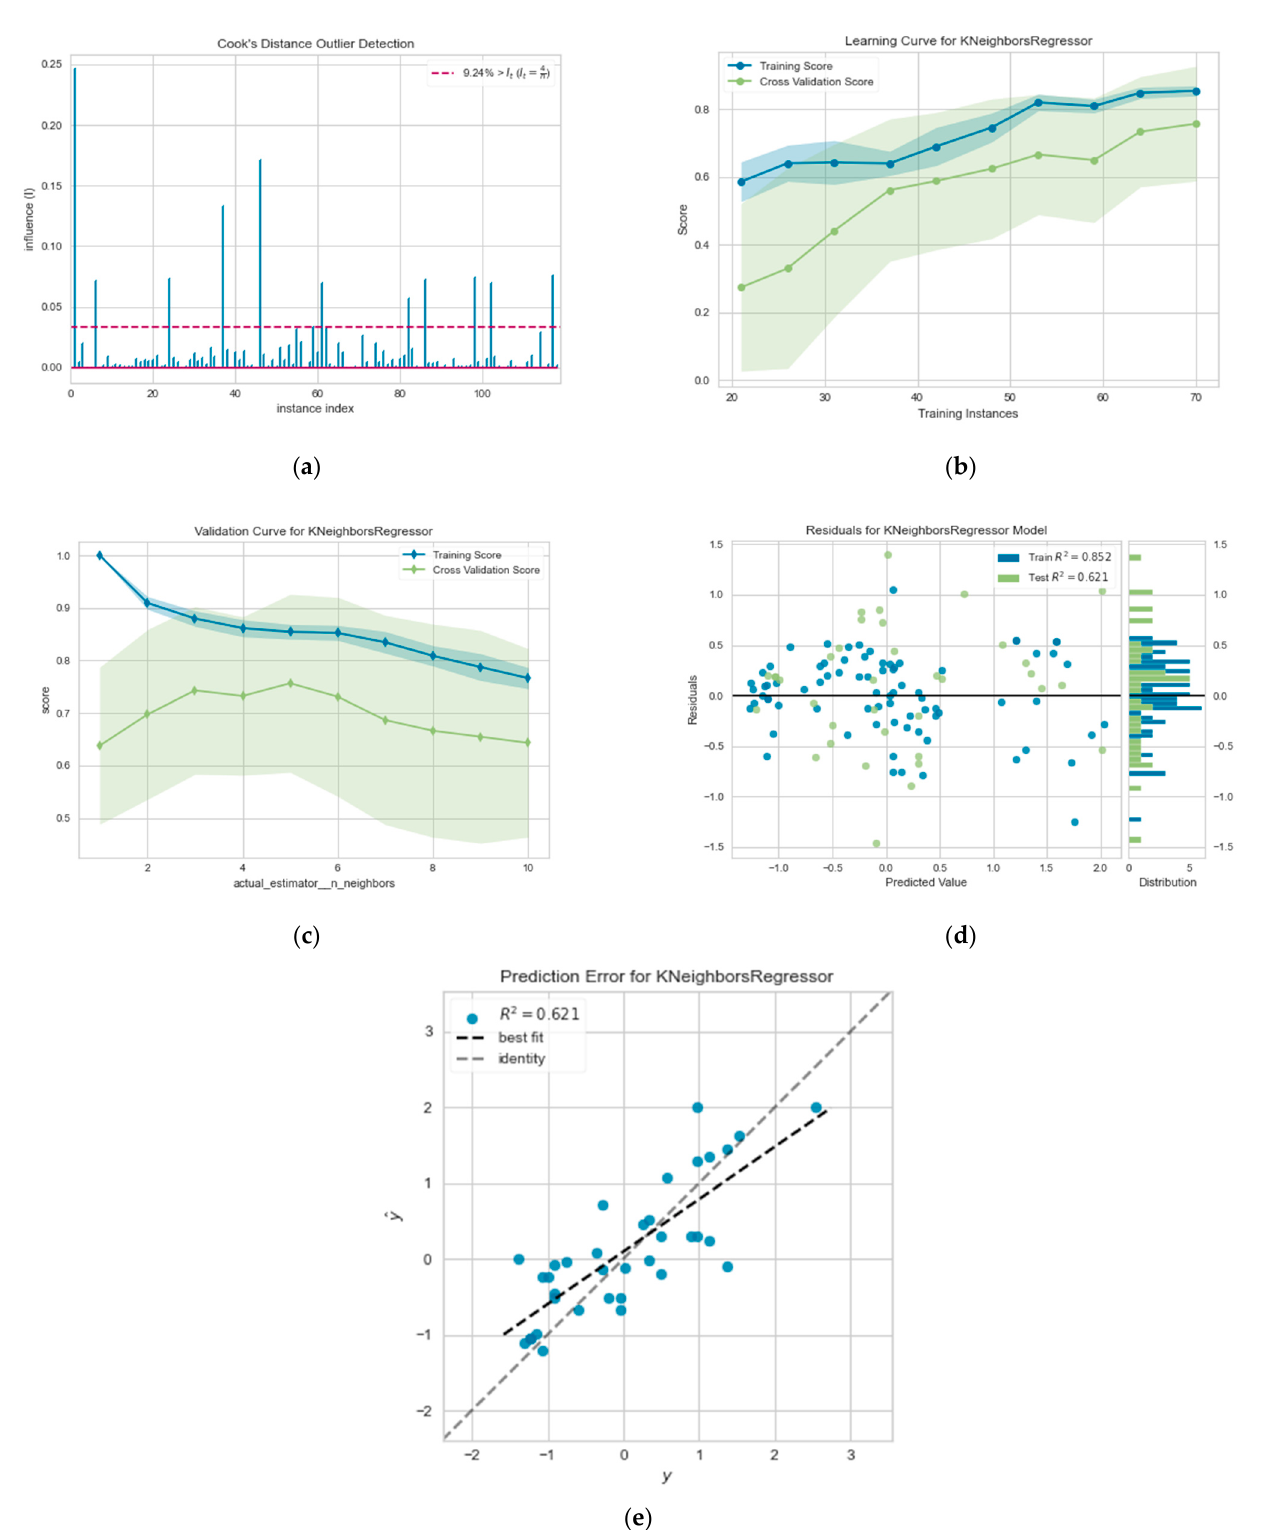
Figure 8. K Neighbors regression model to predict the above-ground Brachiaria using the GTD and UAV remote sensing features. ( a ) Cook distance for outlier detection, ( b) learning curve plot, ( c ) validation curve plot, ( d ) residual plot in the first fold as training and testing, ( e ) prediction error scatterplot with testing data identifying y as the observed values and ˆy as the predicted